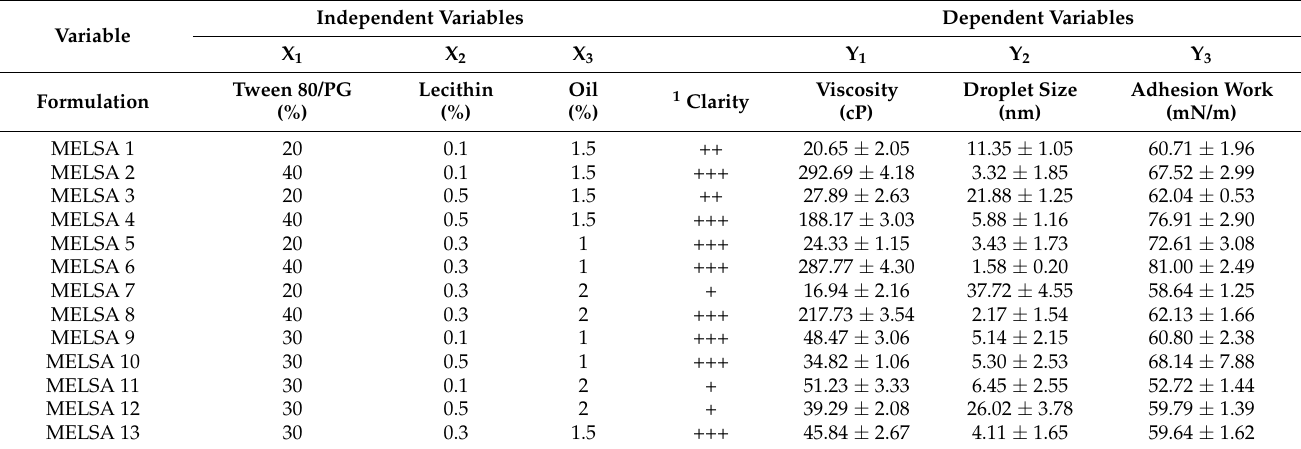
Table 7. Optimization parameters presented as function of independent variables analyzed using response surface methodology for microemulsions MELSA 1–MELSA 13. Independent